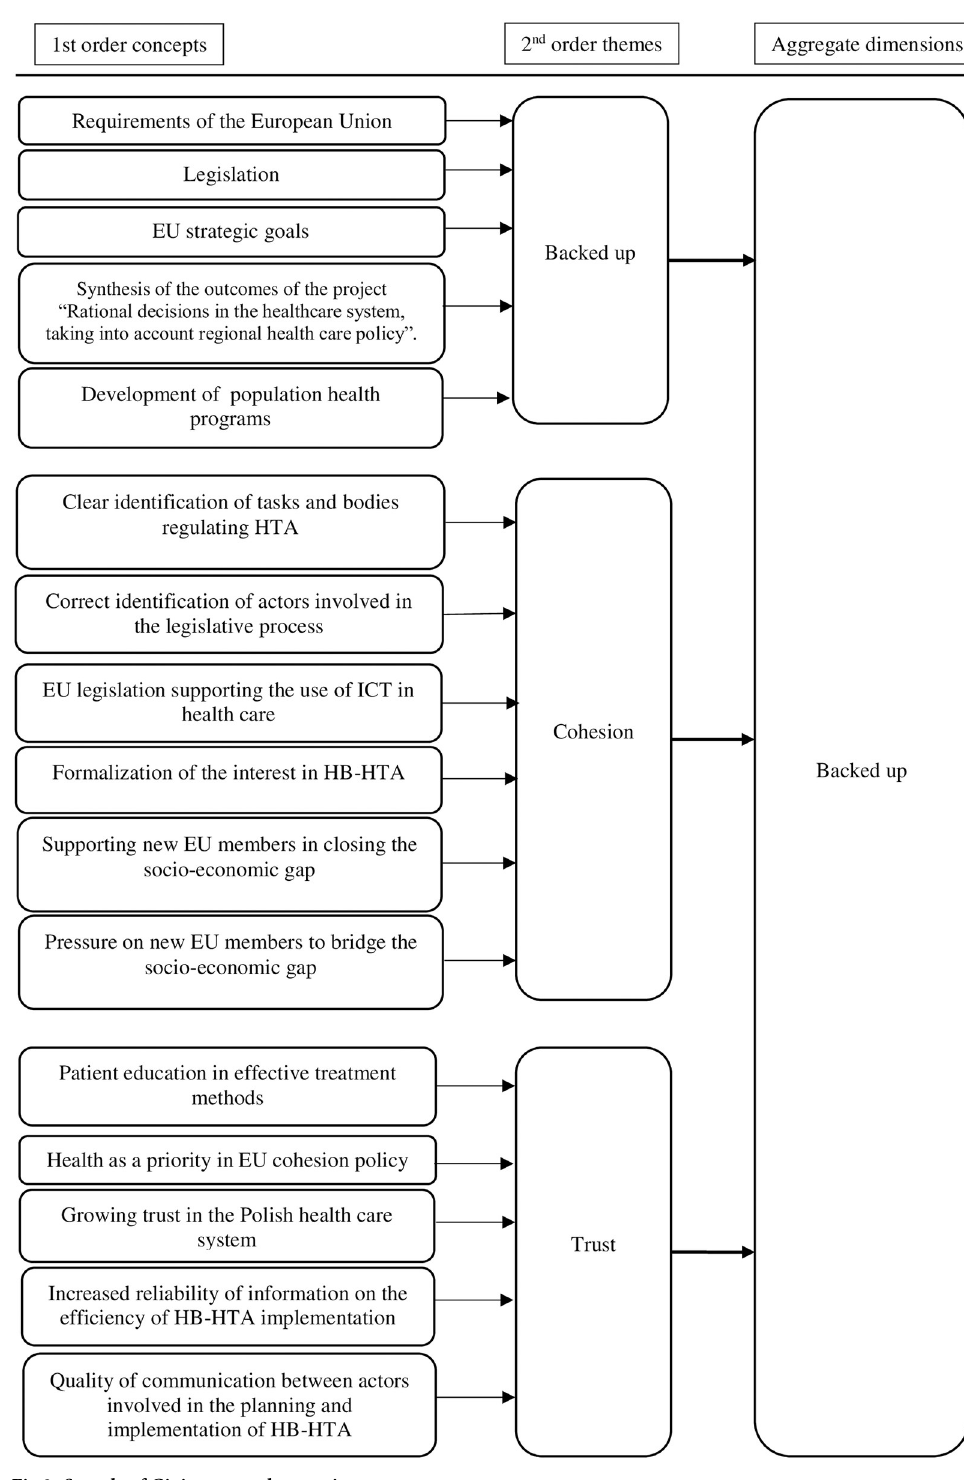
Fig 2. Sample of Gioia approach grouping